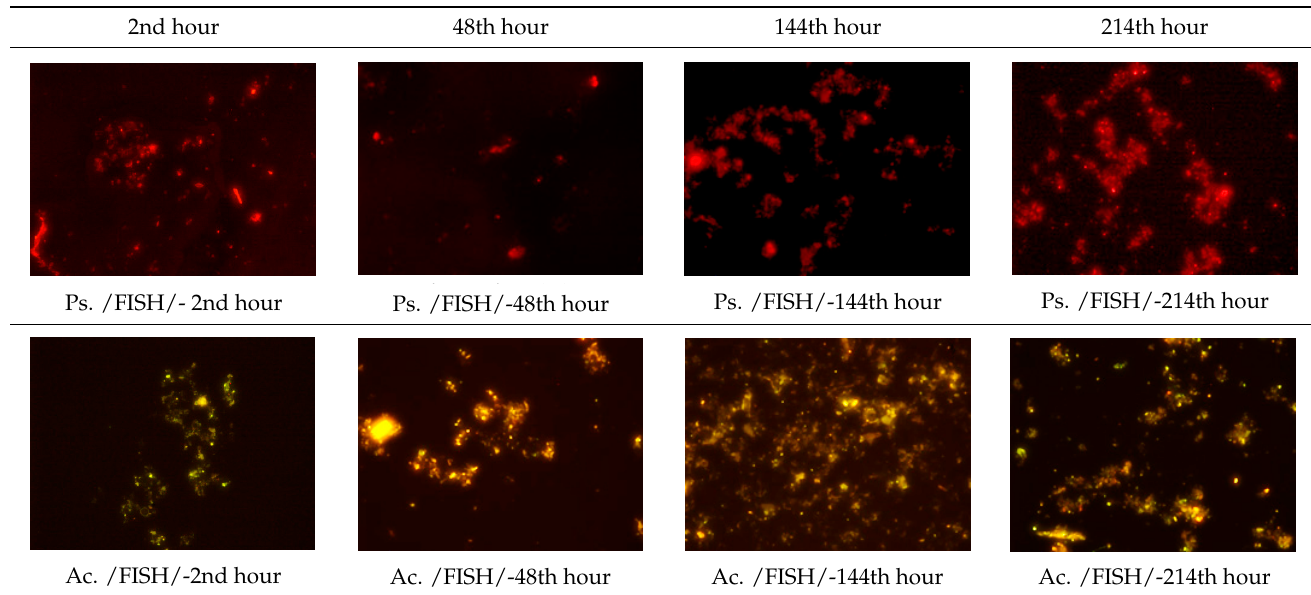
Table 4. Fluorescent images of the microbial community for the variant PhND (400X). Subjects were represented by hybridization with an oligonucleotide probe specific to the genus Pseudomonas (red) and the genus Acinetobacter (yellow).